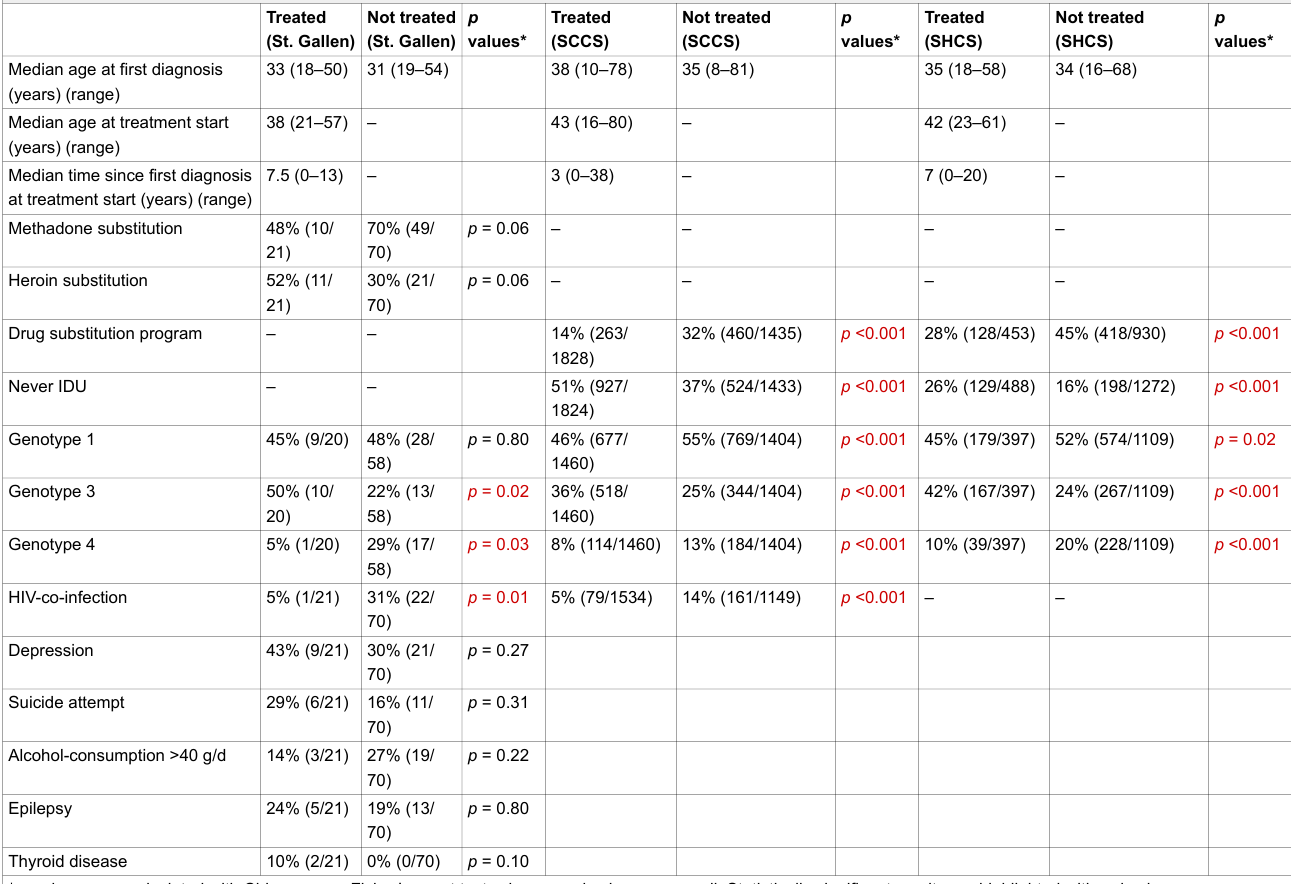
Supplementary table 3: Characteristics of patients treated versus not treated for hepatitis C (St. Gallen, SCCS, SHCS).